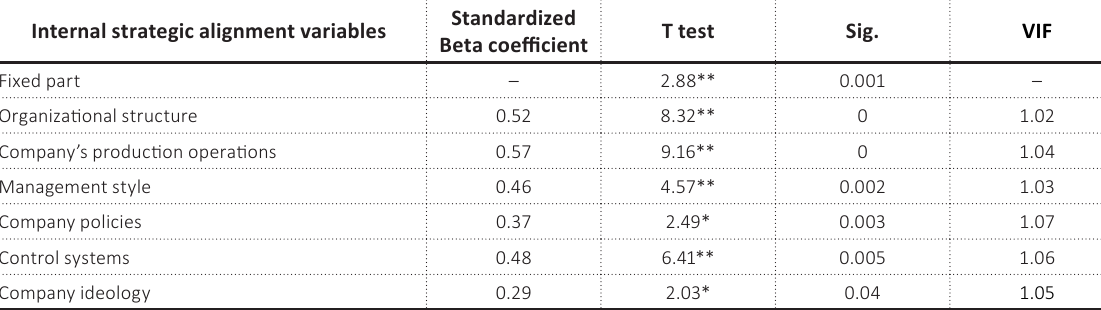
Table 8. Impact of internal strategic alignment on company image and